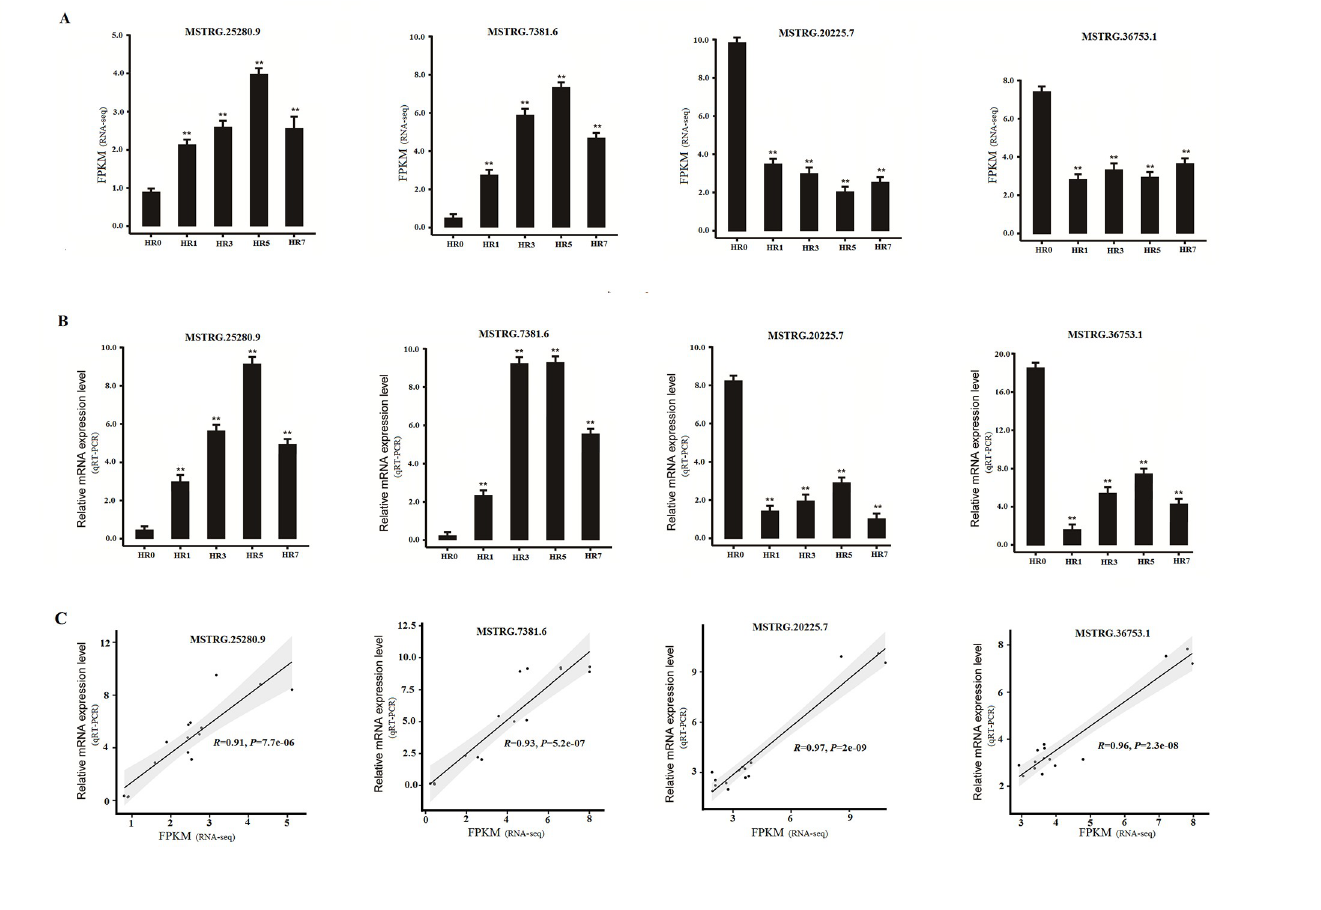
Fig 4. Quantitative real-time PCR (qRT-PCR) validation of some differentially expressed (DE) lncRNAs obtained from RNA sequencing (RNA-seq). (A) The relative expression levels of some DE lncRNAs were determined by RNA-seq. FPKM (fragments per kilobase per million mapped fragments) was used to calculate the expression levels of genes or lncRNAs. (B) The relative expression levels of the DE lncRNAs above were validated by qRT-PCR, normalized with the ACT3 gene. Three replicates were used for RT-qPCR experiments. (C) The correlation analyses for the data between the qRT-PCR and RNA-seq using the Pearson’s correlation coefficients (PCCs). Data represent the mean values ± SD. � , P < 0.05; �� , P < 0.01, calculated with student’s t test.